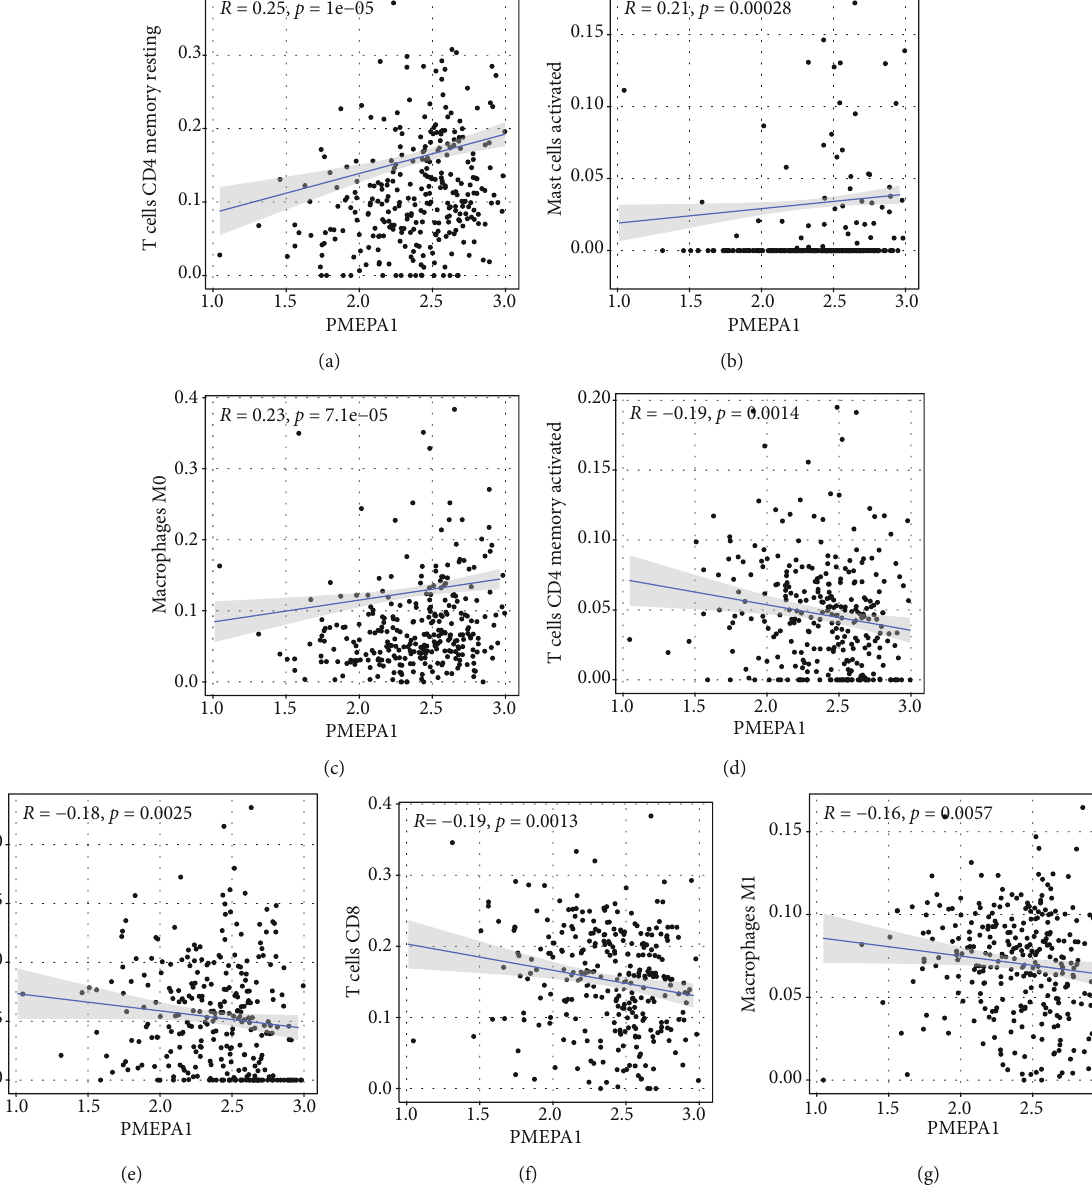
Figure 8: Correlation of TICs percentage with the expression of PMEPA1. Scatter plot displayed the correlation of 8 types of TICs percentage with the expression of PMEPA1 ( P < 0 : 05 ), such as (a) T cells CD4 memory resting, (b) mast cells activated, (c) macrophages M0, (d) T cell CD4 memory stimulated, (e) dendritic cells resting, (f) T cell CD8, and (g) macrophagus M1. The correlation examination was completed via Pearson coe ffi